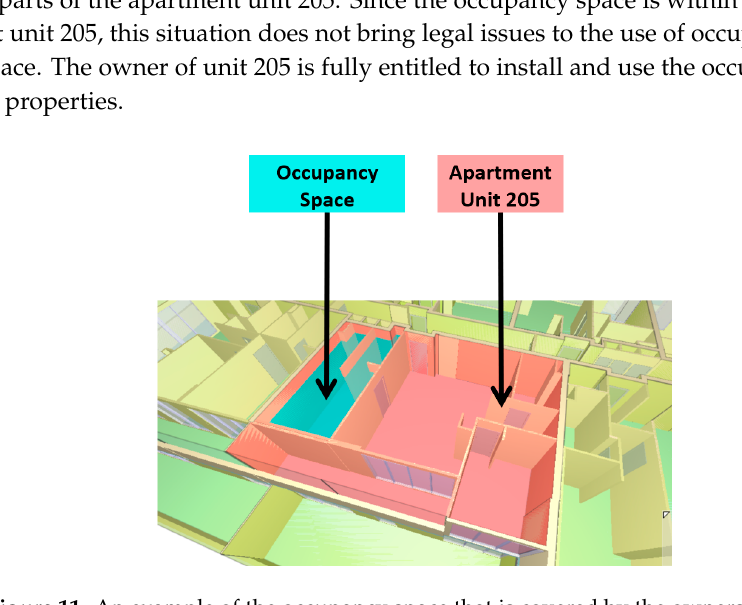
Figure 11. An example of the occupancy space that is covered by the ownership space.